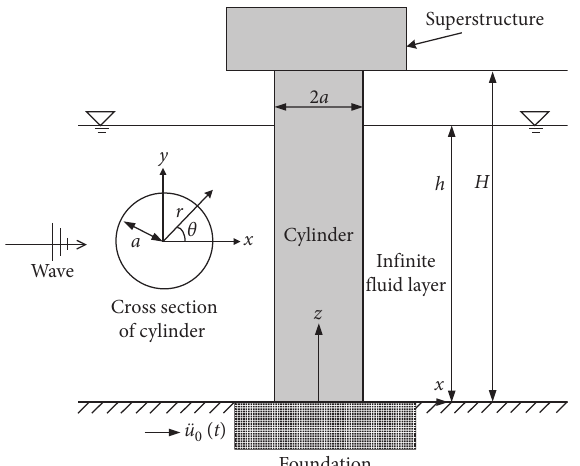
Figure 1: The fluid-structure interaction problem with rigid foundation.